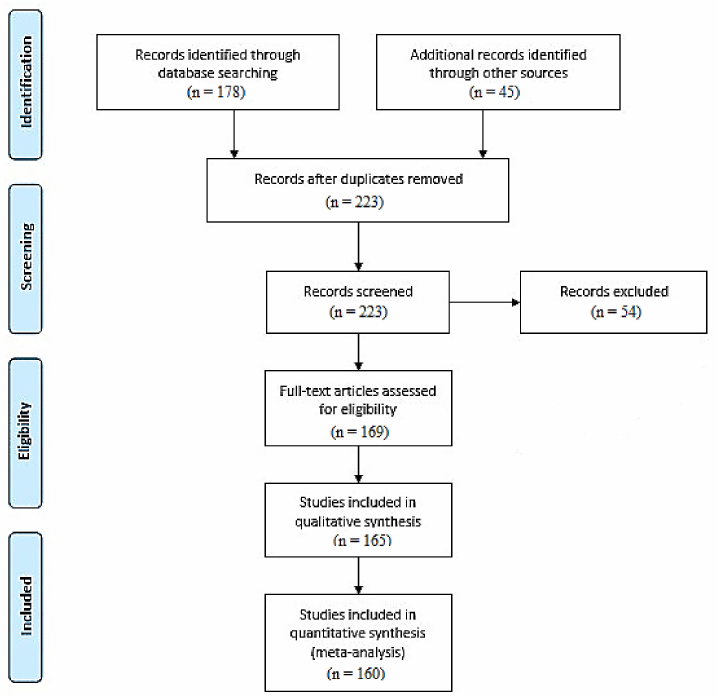
Figure 1. PRISMA-based flow diagram of the meta-analysis process performed